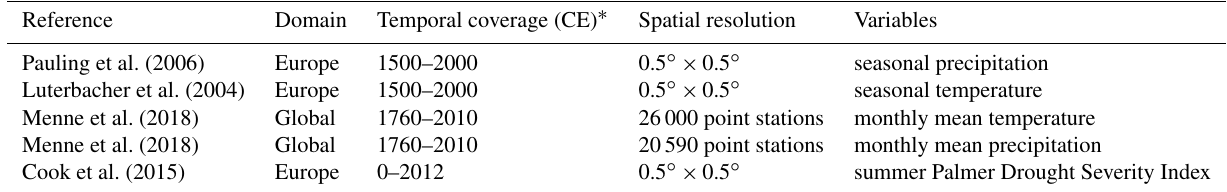
Table 1. Summary of considered datasets.